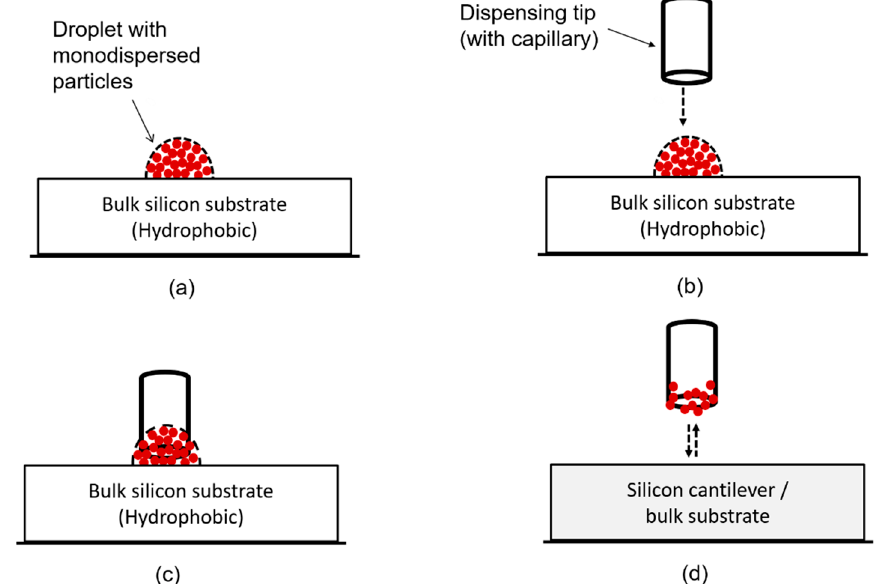
Figure 5. Schematic illustration of the particle sampling and deposition by particle-imprinting process. ( a ) Arbitrary sized droplet containing monodispersed particles on a hydrophobic silicon surface. ( b ) The dispensing stainless-steel tip is positioned above the droplet and then moved (using a 3D micro-positioning system) into the droplet. ( c ) The tip is dipped into the particles-laden droplet to coat it with the particles solution. ( d ) After retraction from the droplet, the particles-coated tip is moved onto the sensing surface to contact and deposit the particles thereon before it is retracted therefrom.